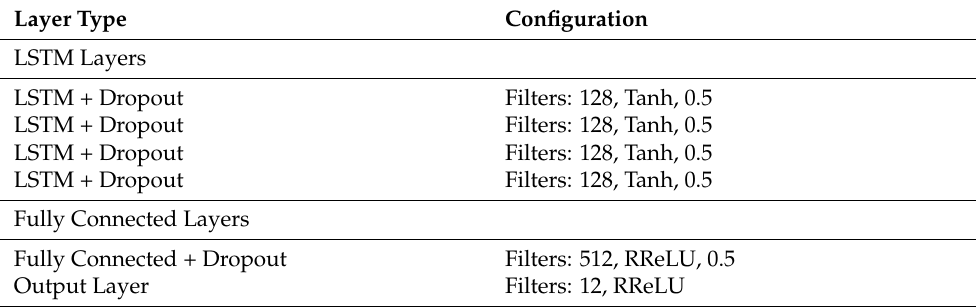
Table 4. The architecture of